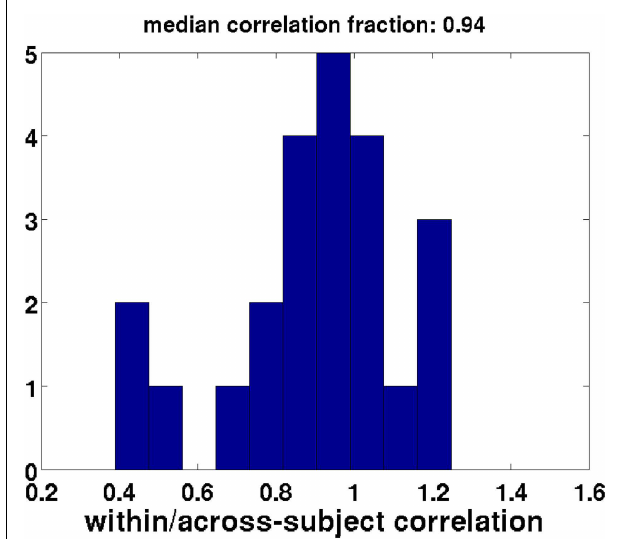
FIGURE 10 |Validation of the subset method: within-subject correlation of weighted regressors with EEG data divided by the across-subject canonical correlates. Perfect validity of the subset method would yield a fraction of one (within-subject correlations equal to across-subject canonical correlation). Each datapoint used to create this histogram reflects a single participant.This distribution has a mean that is not different from